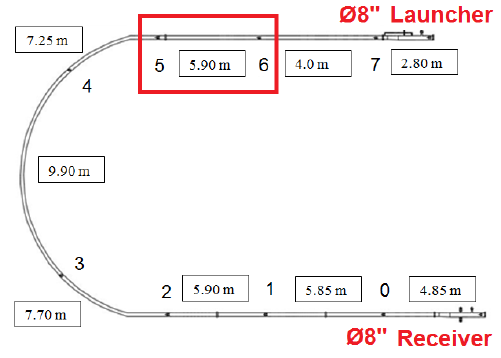
Figure 12. Position of the transducers analyzed in this work. Source: By authors.